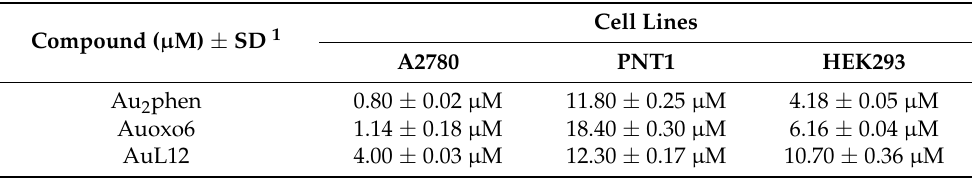
Table 1. Half-maximal inhibitory concentration (IC 50 ) values of the investigated gold compounds after 72 h of treatment using MTT